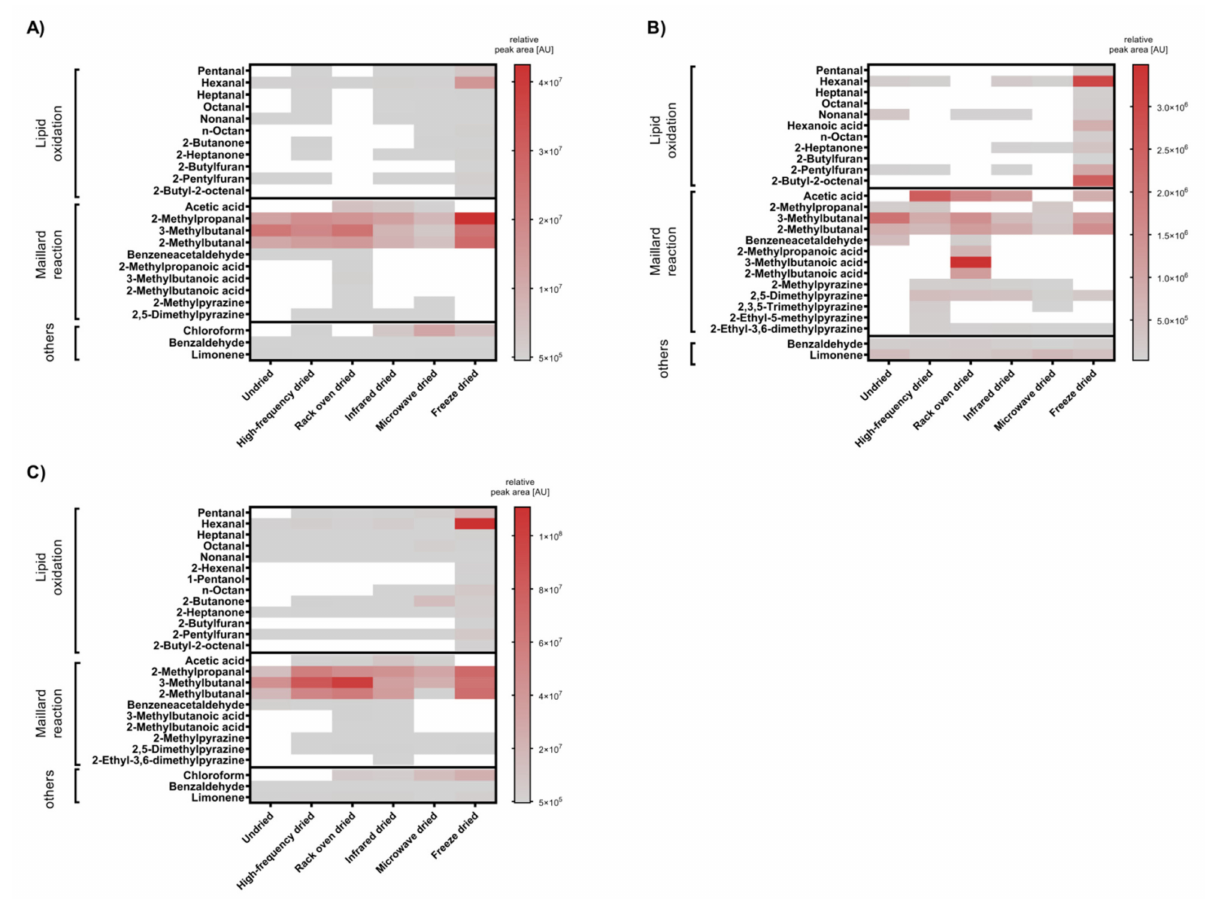
Figure 1. Heatmaps of volatile compounds from mealworm larvae detected by ( A ) static HS ( B ) HS- SPME or ( C ) HS-ITEX GC-MS. Shown are the mean values of the peak area of volatile organic compounds relative to larval weight. (N ≥ 3); white areas= volatile component was not